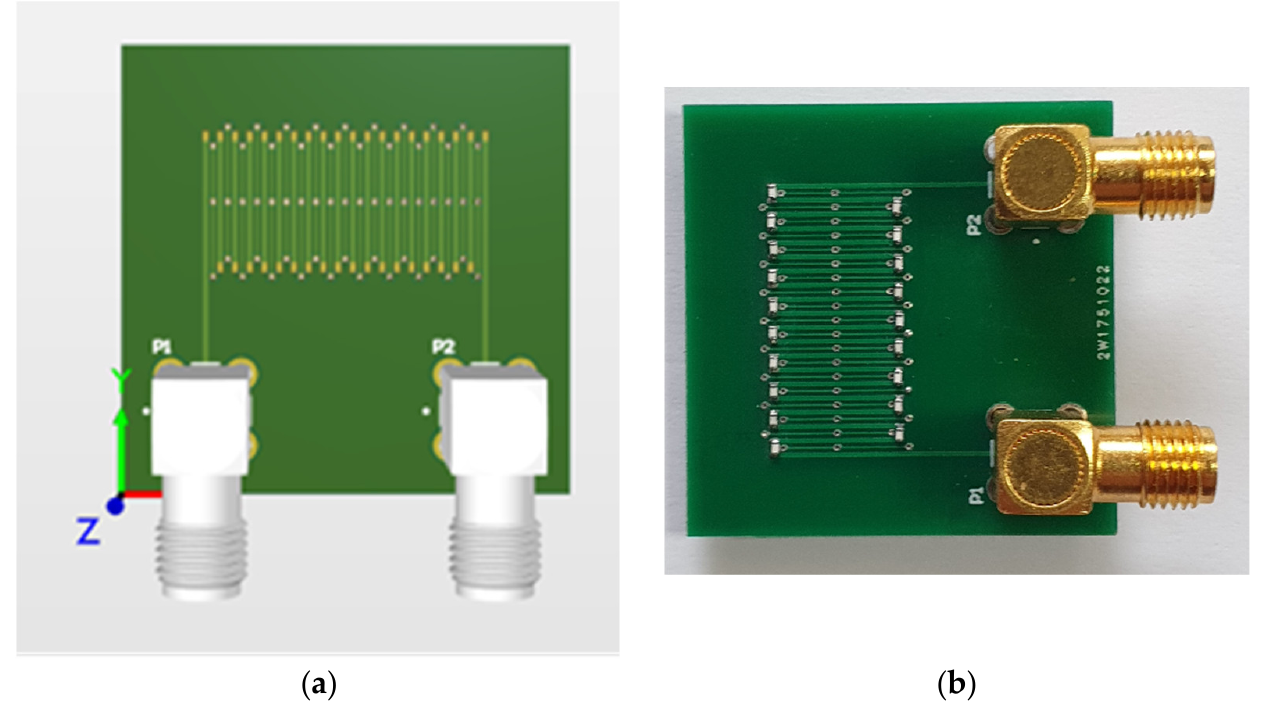
Figure 3 . The ( a ) PCB model and ( b ) manufactured prototype of the hybrid meander structure. Figure 3. The ( a ) PCB model and ( b ) manufactured prototype of the hybrid meander